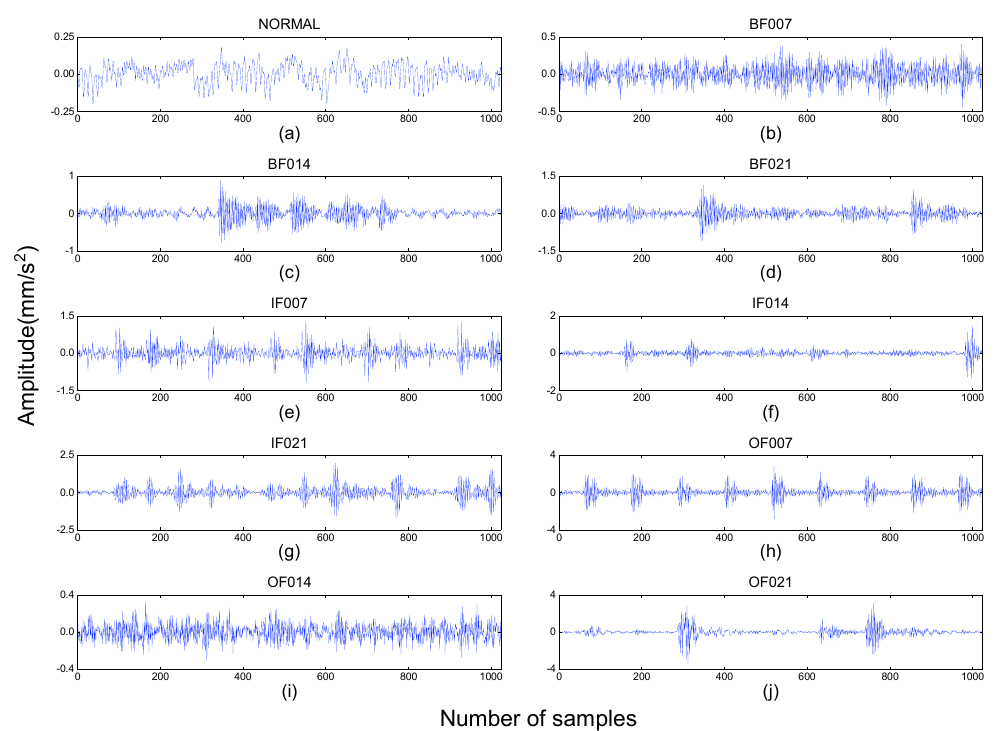
Figure 5. Vibration signals of bearing: ( a ) normal; ( b ) ball fault (007); ( c ) ball fault (014); ( d ) ball fault (021); ( e ) inner fault (007); ( f ) inner fault (014); ( g ) inner fault (021); ( h ) outer fault (007); ( i ) outer fault (014); ( j ) outer fault